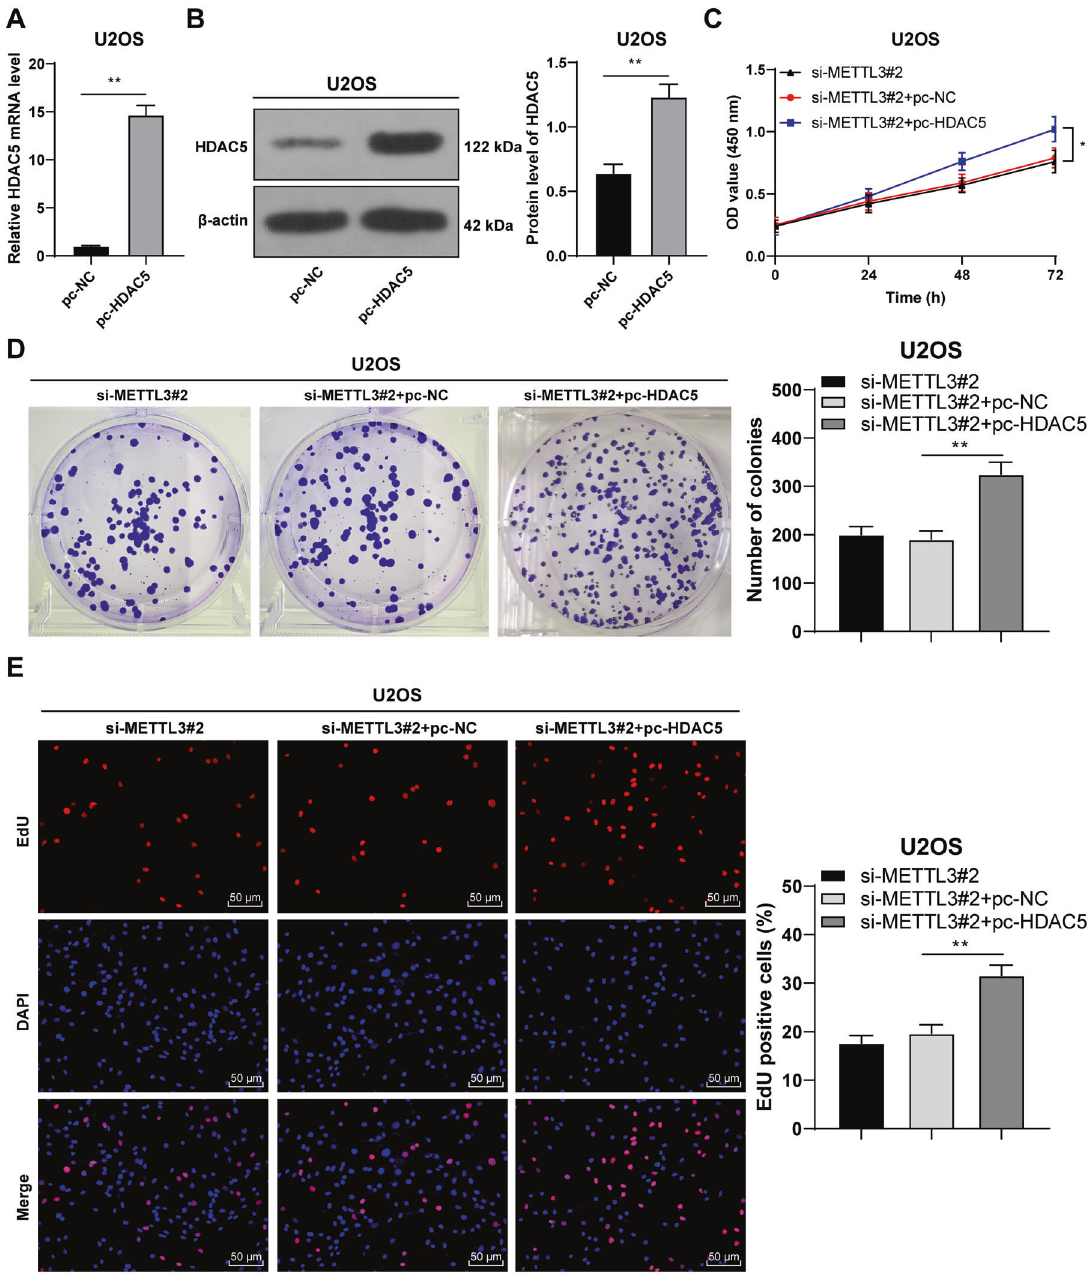
Fig. 4 HDAC5 overexpression partially reversed the inhibitory effect of METTL3 silencing on OS cell proliferation. pcDNA 3.1 HDAC5 (pc- HDAC5) was transfected into U2OS cells, with pc-NC as negative control. After 48 h, A , B HDAC5 expression in U2OS cells was measured using RT-qPCR and western blot. Then, pc-HDAC5-transfected U2OS cells were treated with si-METTL3#2 for 48 h. C – E The proliferation of OS cells was measured using CCK-8 assay ( C ), colony formation assay (14 days) ( D ), and EdU staining ( E ). The cell experiment was repeated three times independently. Data are presented as mean ± standard deviation. Data in panels A , B were analyzed using t -test. Data in panels D , E were analyzed using one-way ANOVA, and data in panel C were analyzed using two-way ANOVA, followed by Tukey ’ s multiple comparisons test, * p < 0.05, ** p <